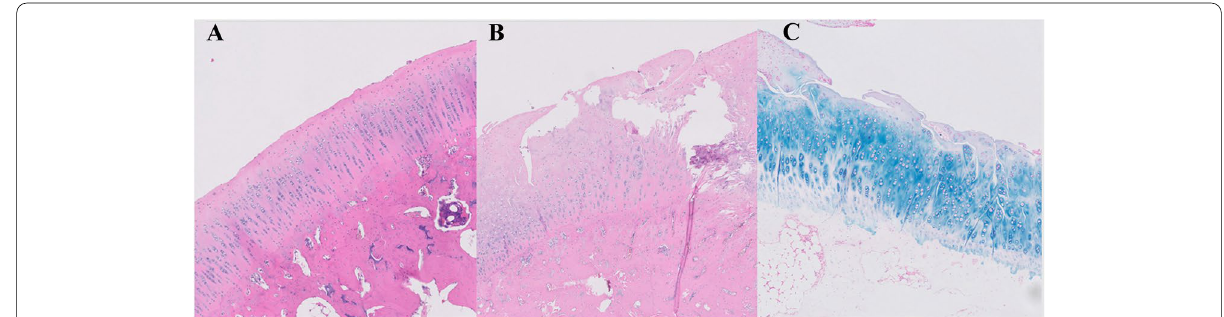
Fig. 5 Hematoxylin eosin (5 A , 5 B ) and alcian blue staining (5 C ) of articular cartilage samples. The cartilage shows a normal appearance, the surface is smooth, chondrocytes are present throughout, and the matrix staining is homogeneous in the control knee (5 A ). The superficial and intermediate layers of cartilage are lost, and matrix vertical fissures reach the deep radial zone in this sample corresponding to an ulcer at the weight bearing area from an OA knee in animals subjected to meniscal root injury and partial meniscectomy (5 B , C ). Cellularity is diminished and the normal pattern of distribution in columns is lost. Cartilage matrix is loss with delamination and excavation of superficial and mid layer (5 B , C ). Marked structural abnormalities and hypocellularity are also evident. Matrix staining intensity is severely reduced (